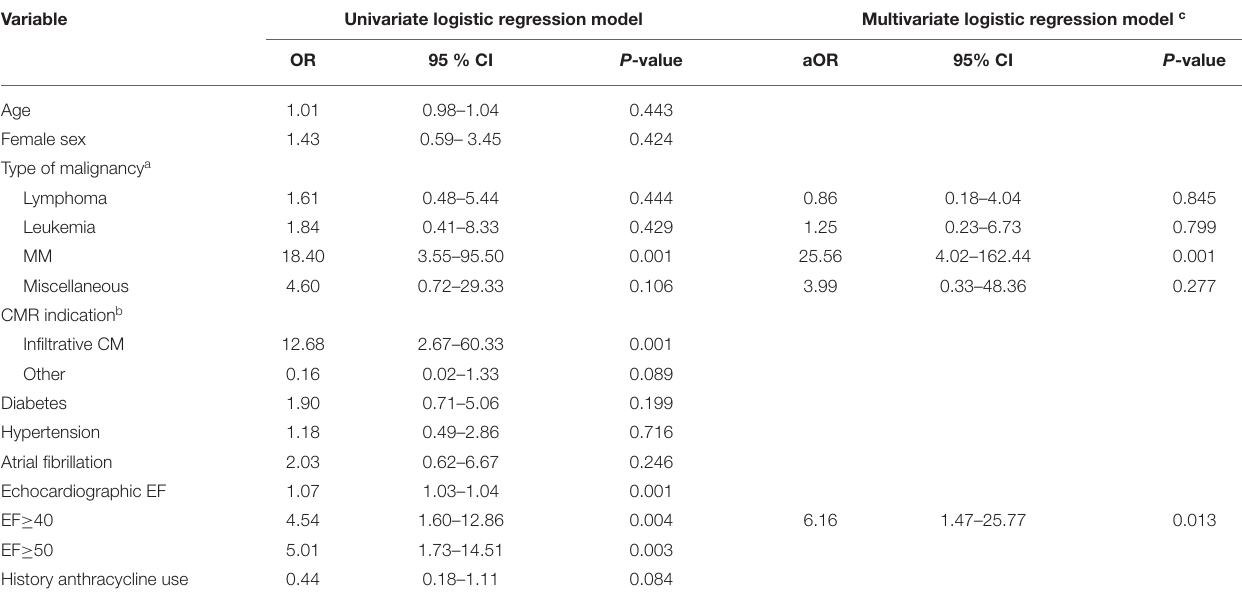
TABLE 7 | Selected univariate and multivariate analysis of factors predicting management change following CMR.